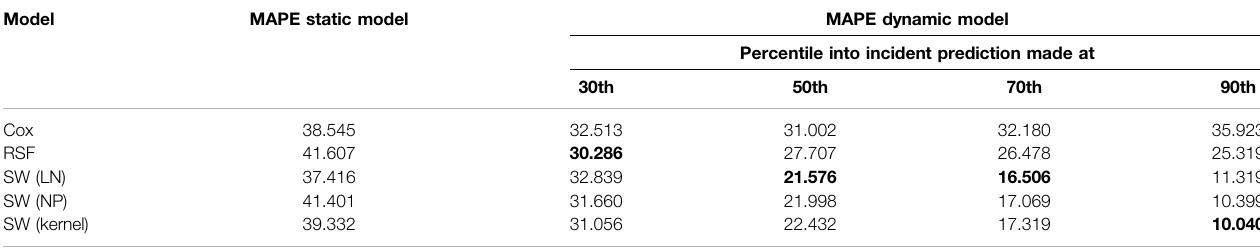
Bold values indicates optimal achieved